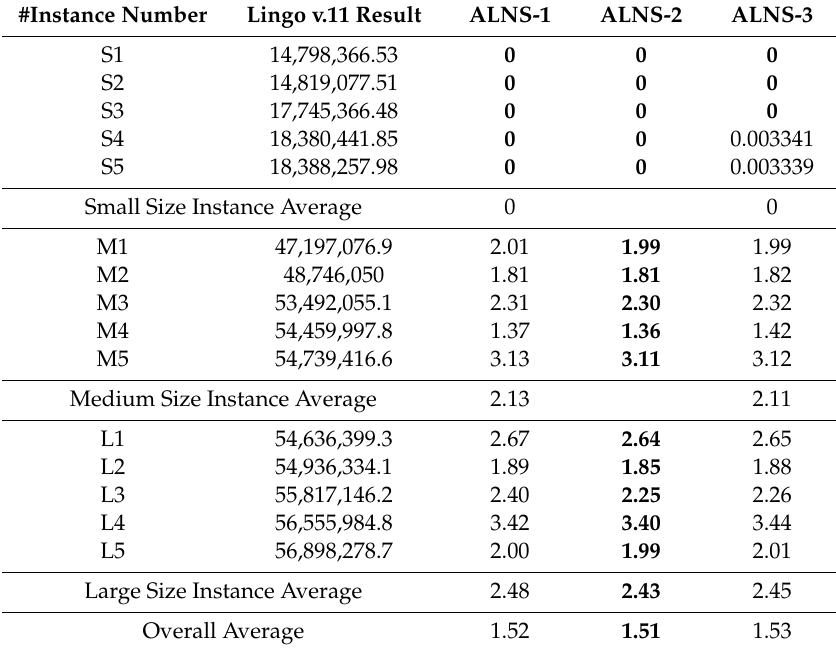
Table 4. The percentage di ff erence of Lingo v.11 and the proposed methods.